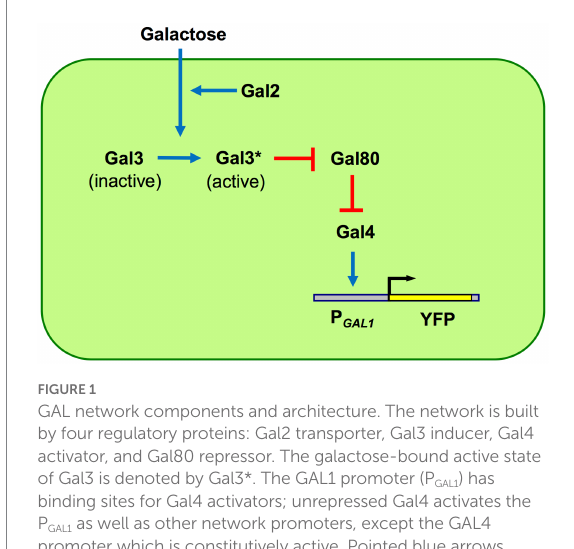
FIGURE 1 GAL network components and architecture. The network is built by four regulatory proteins: Gal2 transporter, Gal3 inducer, Gal4 activator, and Gal80 repressor. The galactose-bound active state of Gal3 is denoted by Gal3*. The GAL1 promoter (P GAL1 ) has binding sites for Gal4 activators; unrepressed Gal4 activates the P GAL1 as well as other network promoters, except the GAL4 promoter which is constitutively active. Pointed blue arrows reflect activation while blunt red arrows reflect inhibition. Network activity is reported using a P GAL1 -YFP